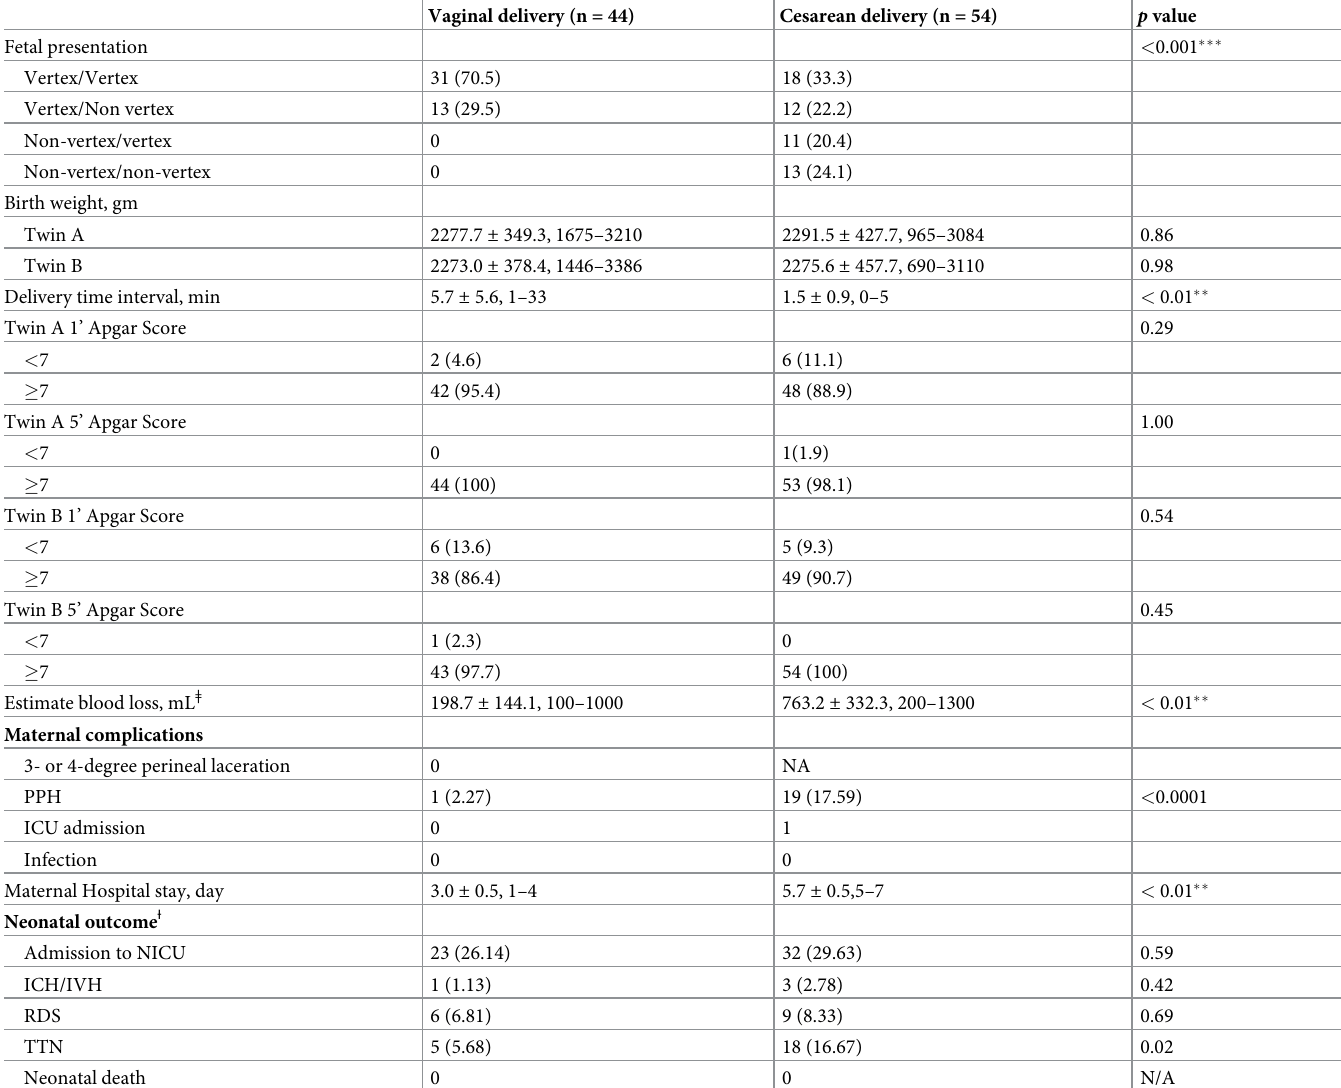
Table 2. Maternal delivery and neonatal